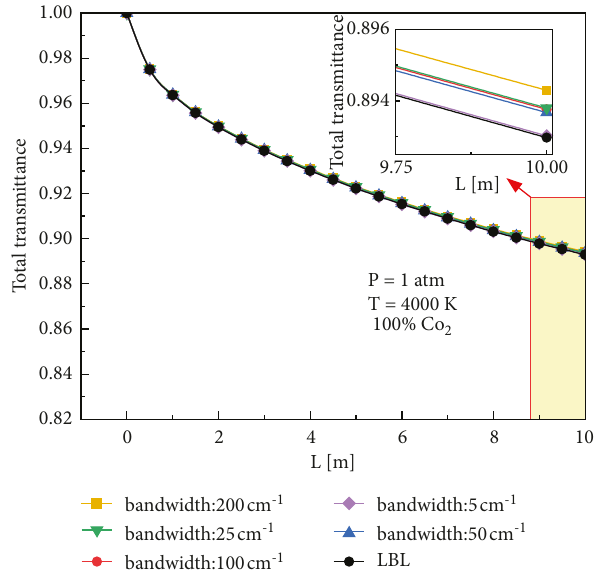
Figure 3: Effect of bandwidth on the total transmittance.